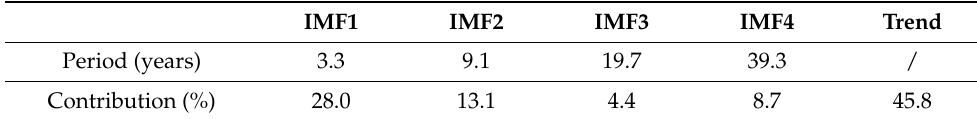
Table 1. Contribution and period of temperature components after EEMD.